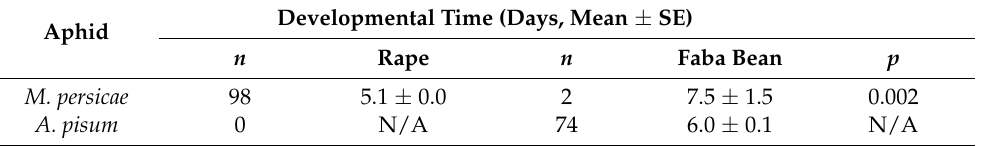
Table 2. Developmental time from first-instar nymph to adult of M. persicae and A. pisum reared on rape versus on faba